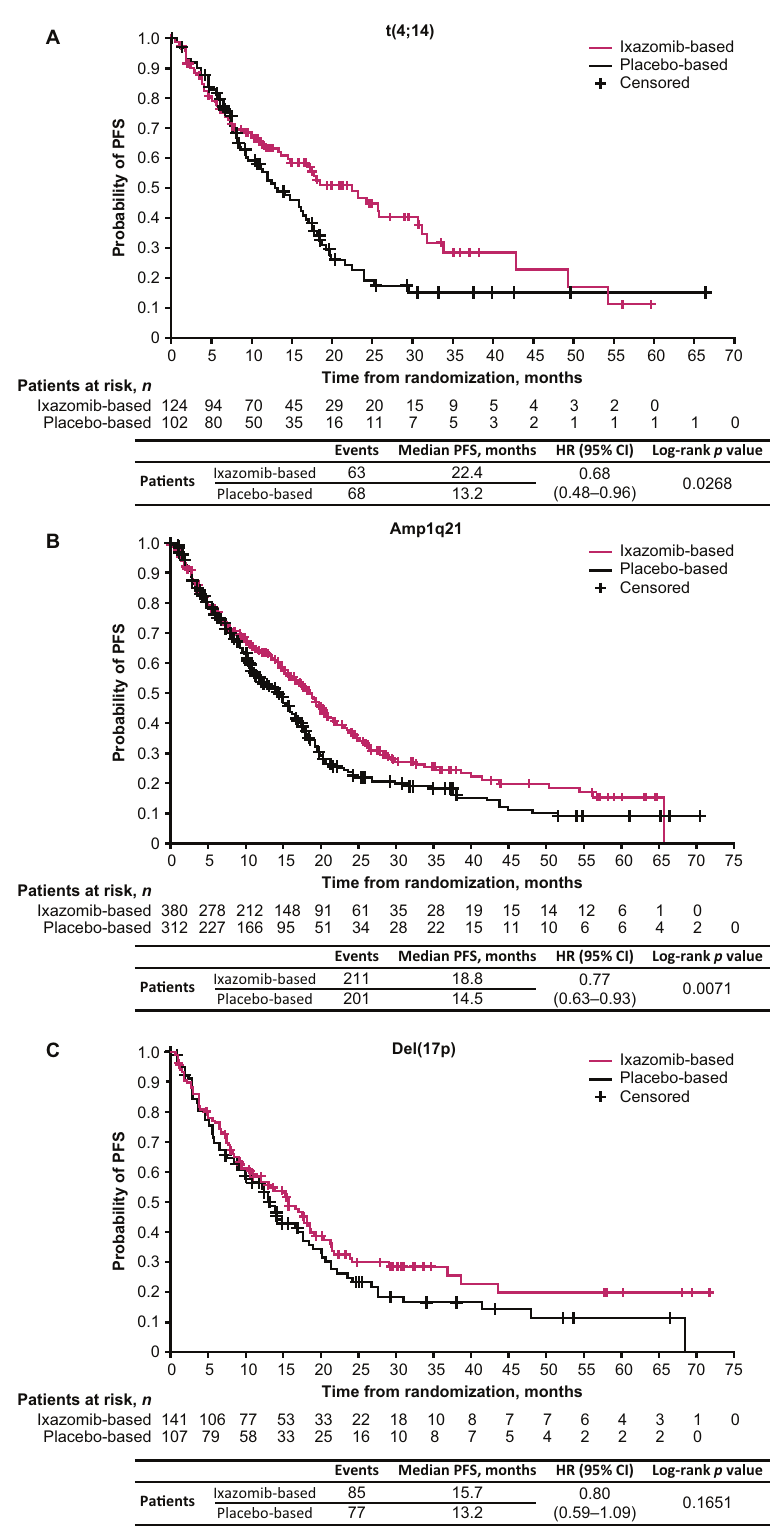
Fig. 4 Kaplan – Meier estimates of PFS for patients with speci fi c cytogenetic abnormalities receiving ixazomib- vs placebo-based therapy. A t(4;14) cytogenetic abnormality, B amp1q21 cytogenetic abnormality, and C del(17p) cytogenetic abnormality. CI con fi dence interval, HR hazard ratio, PFS progression-free